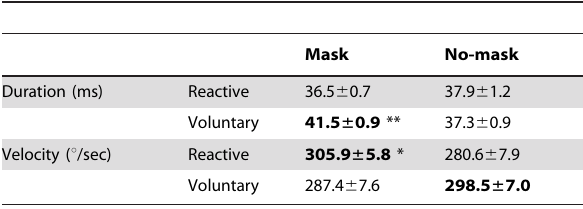
Table 1. Baseline of saccade duration and peak velocity (pre- adaptation